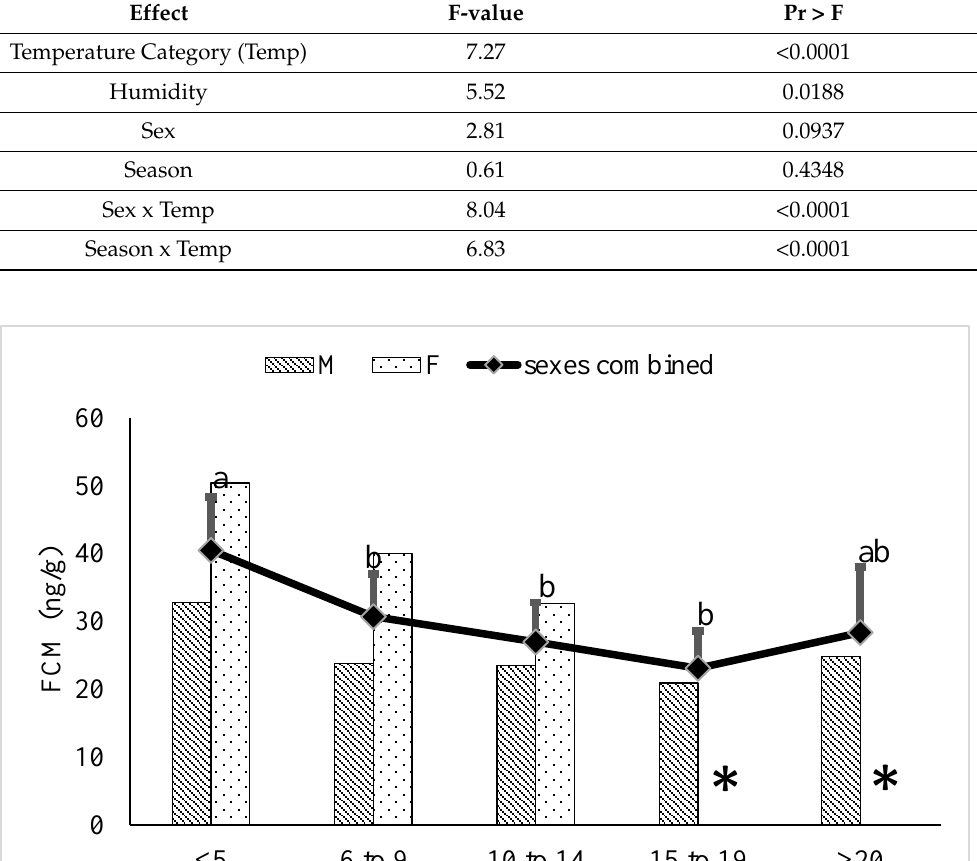
Figure 5. Back-transformed LSMeans ± SEM for fecal cortisol metabolite (FCM) concentrations (ng/g dry feces) within different ambient temperature categories for adult (6–17 years) polar bears during